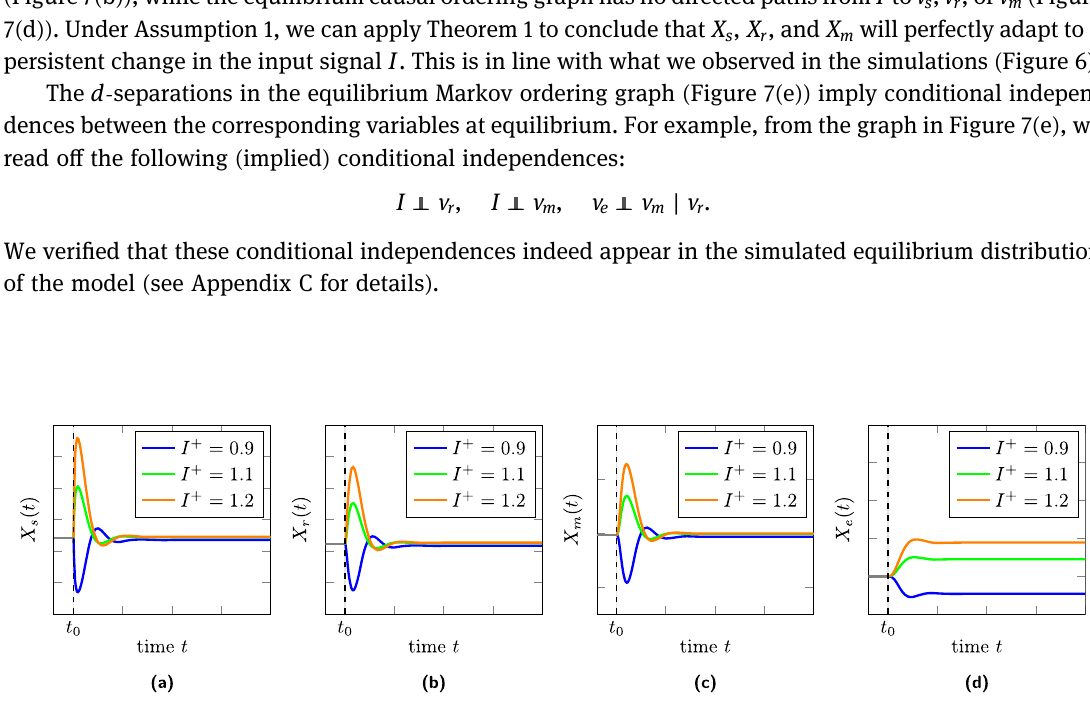
Figure 6: Perfect adaptation in the model for the RAS - RAF - MEK - ERK signalling pathway. After an initial response to a change of the input signal from value I 1.0 − = to a value I + at time t t 0 = , the equilibrium concentrations of active RAS, RAF, and MEK revert to their original values, while the concentration of active ERK changes. Shown are concentrations of active RAS ( a ) , RAF ( b ) , MEK ( c ) and ERK ( d ) against